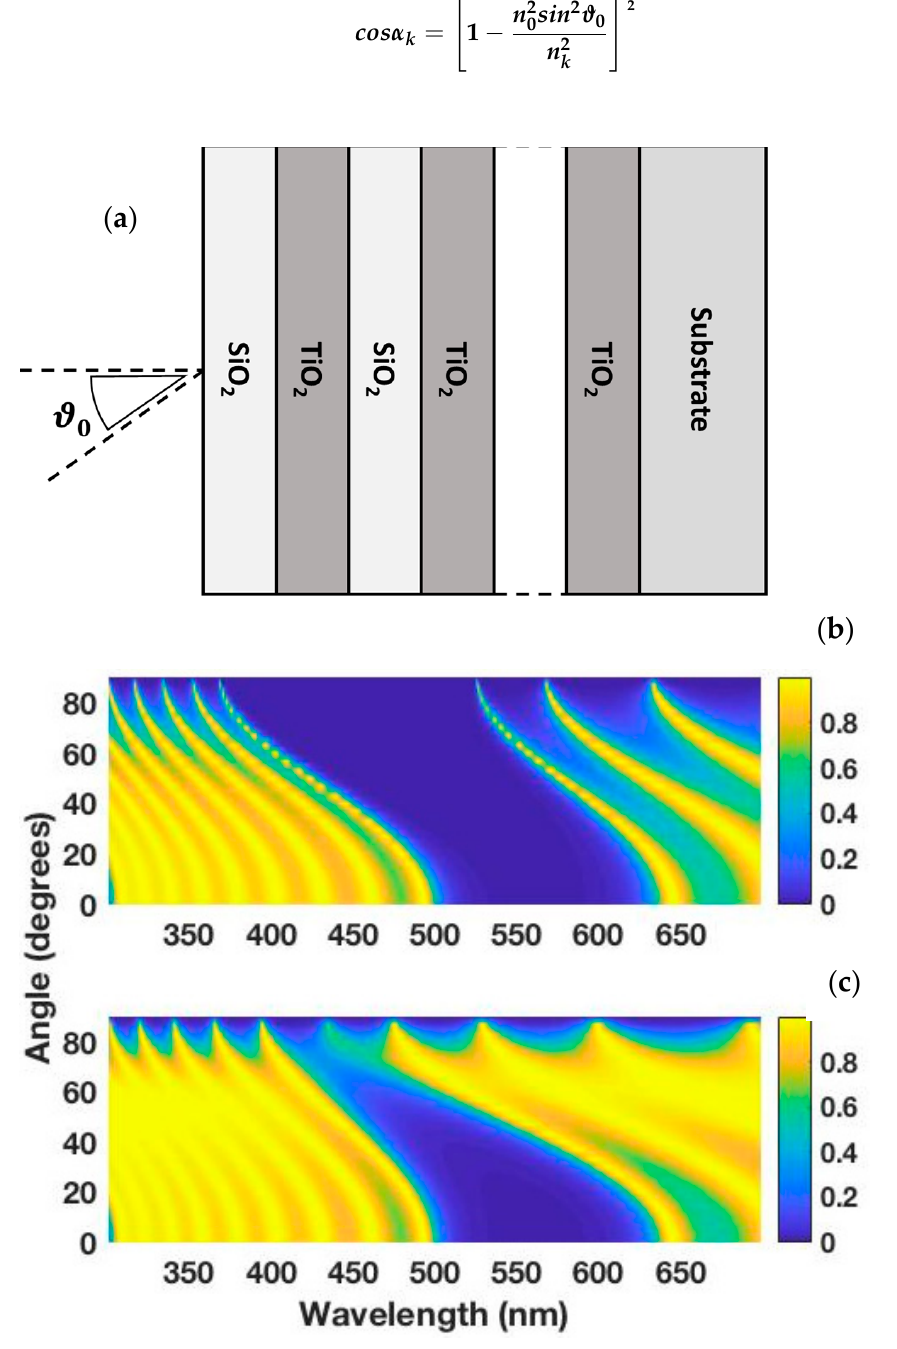
Figure 1. ( a ) Sketch of the one-dimensional photonic crystal ( ϑ 0 is the angle of incidence of the light). Simulation of the angular dependent transmission spectrum of a 5 bilayer TiO 2 -SiO 2 nanoparticle-based photonic crystal for a transverse electric (TE) wave ( b ) and a transverse magnetic (TM) wave ( c ). For both the nanoparticle layers, the filling factor is 0.7.